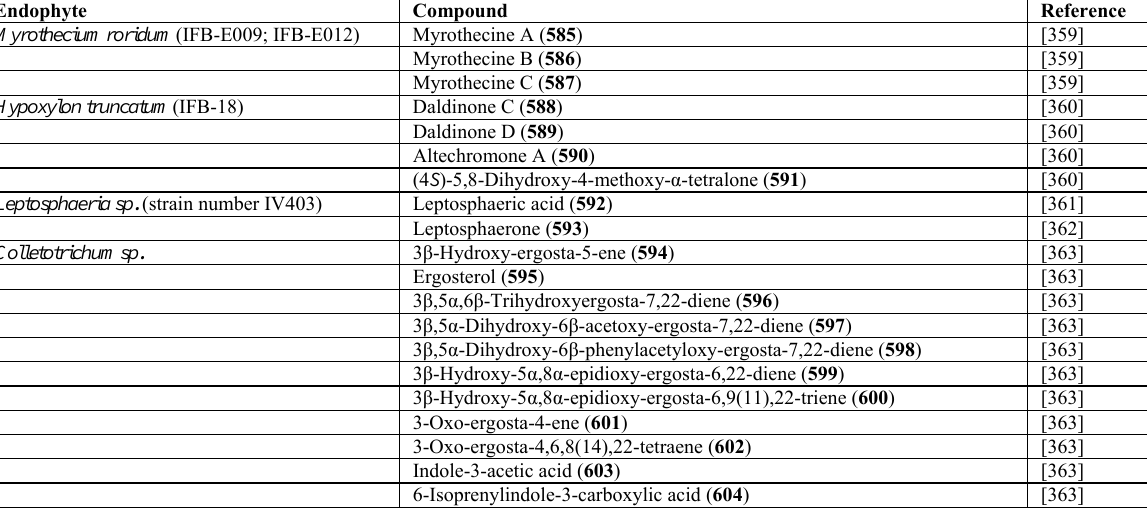
Table 44. Natural Products from Endophytic Fungi Found in A.